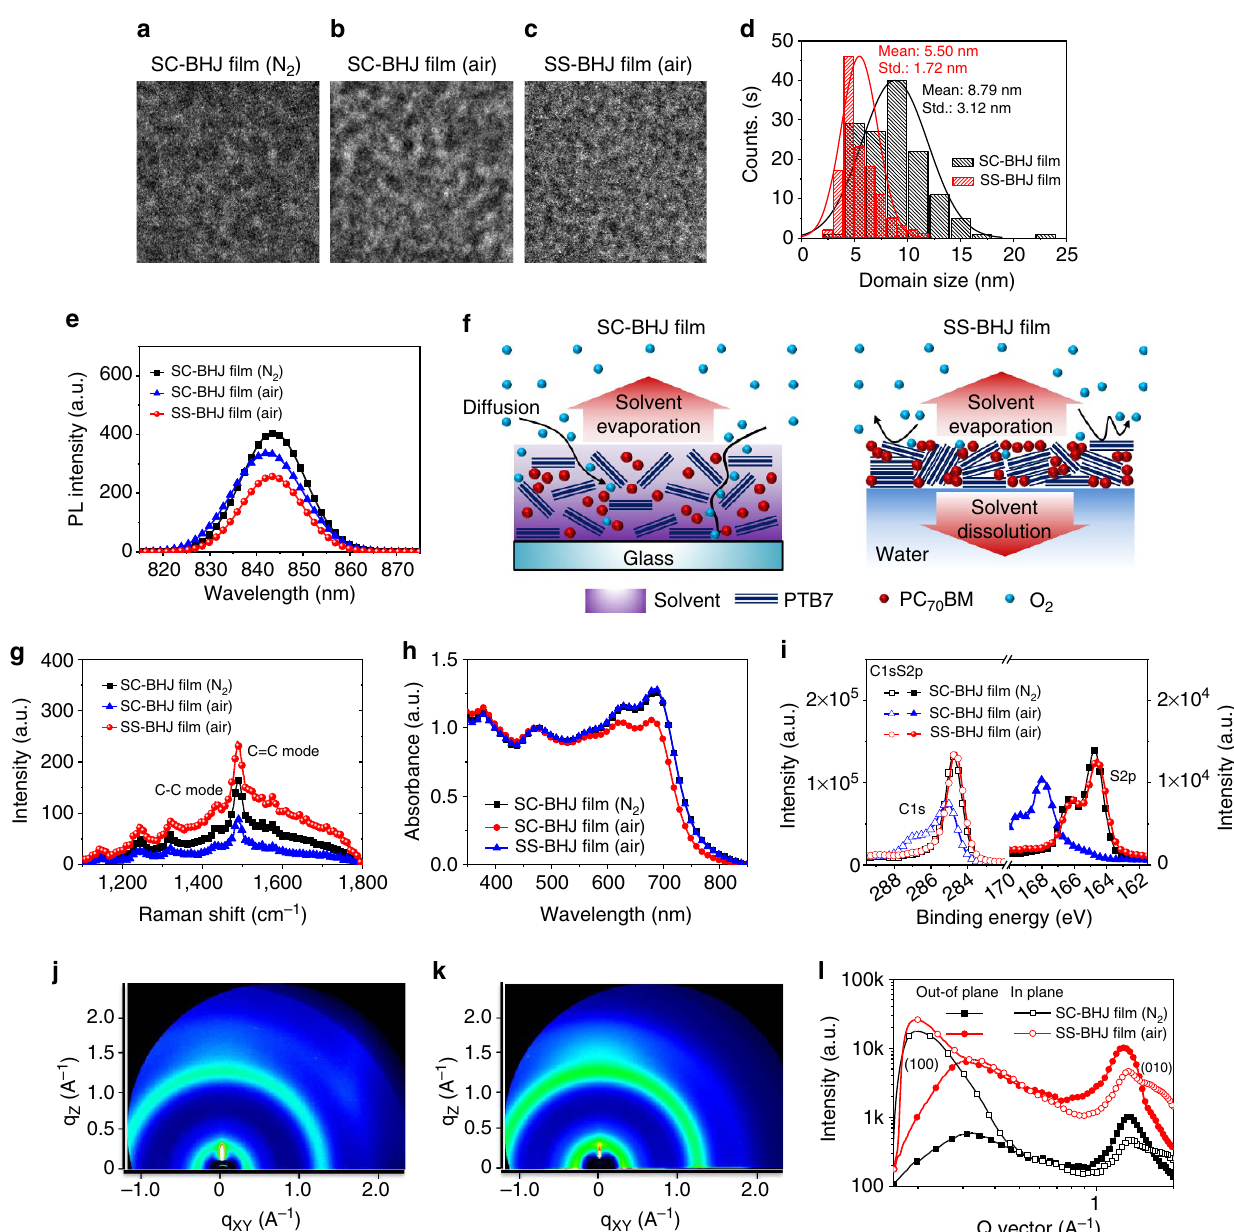
Figure 2 | High-quality polymer from spontaneous spreading process. ( a – c ) TEM images of N 2 processed ( a ) air-processed SC-BHJ ( b ) and SS-BHJ ( c ) films measured at the same defocusing distance. ( d ) PTB7 domain size distribution histograms of N 2 -processed SC-BHJ and SS- BHJ films. ( e ) Photoluminescence spectra of both films when excited at 633nm. ( f ) SC-BHJ and SS-BHJ films immediately after film formation process. ( g – i ) Raman spectra ( g ) and ultraviolet–visible absorption spectra ( h ) for SC-BHJ and SS-BHJ films, and S2p and C1s XPS spectra ( i ) of N 2 and air-processed SC-BHJ, and SS- BHJ films. ( j – l ) 2D GIWAXS images of SC-BHJ ( j ) and SS-BHJ films ( k ) and out-of-plane and in plane GIWAXS profiles ( l